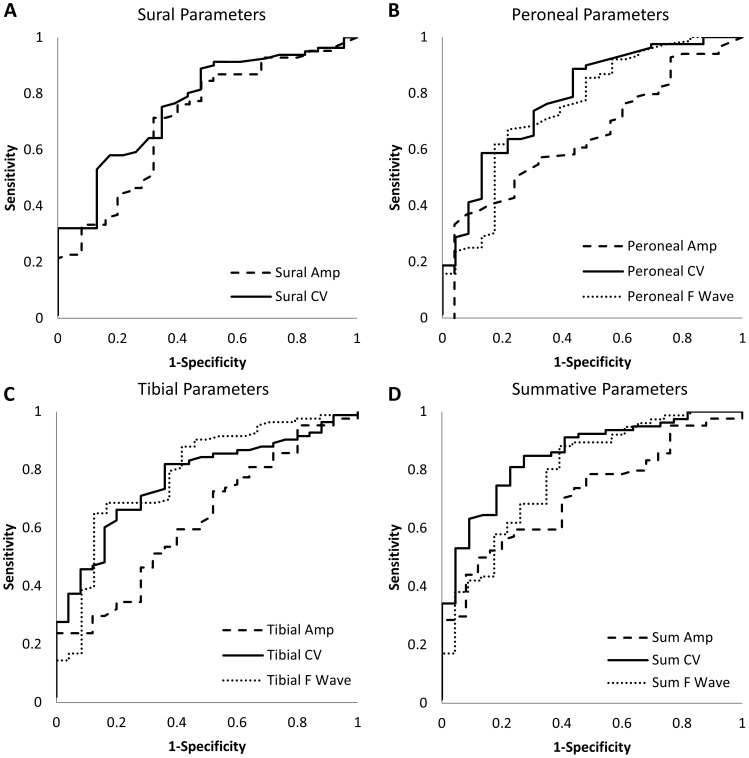
Predictive validity ROC curves for sural, peroneal, tibial and summative parameters.See Table 2 for estimates of AROC for each parameter. Tibial F-wave latency and the sum of sural, peroneal, and tibial conduction velocities had the highest AROC (0.80 and 0.83, respectively). Dashed lines represent amplitude potentials. Solid lines represent conduction velocities. Dotted lines represent F-wave latencies.